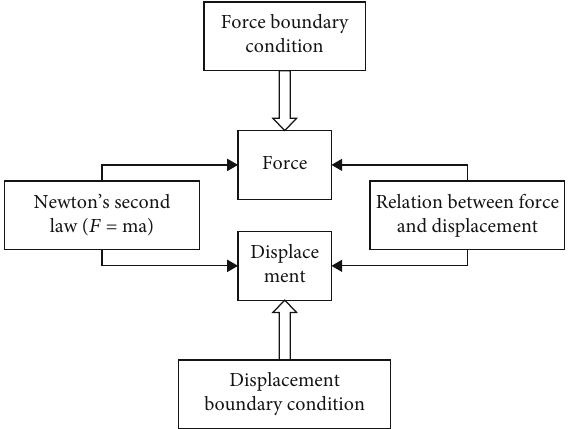
Figure 8: Process diagram of particle fl ow cycle